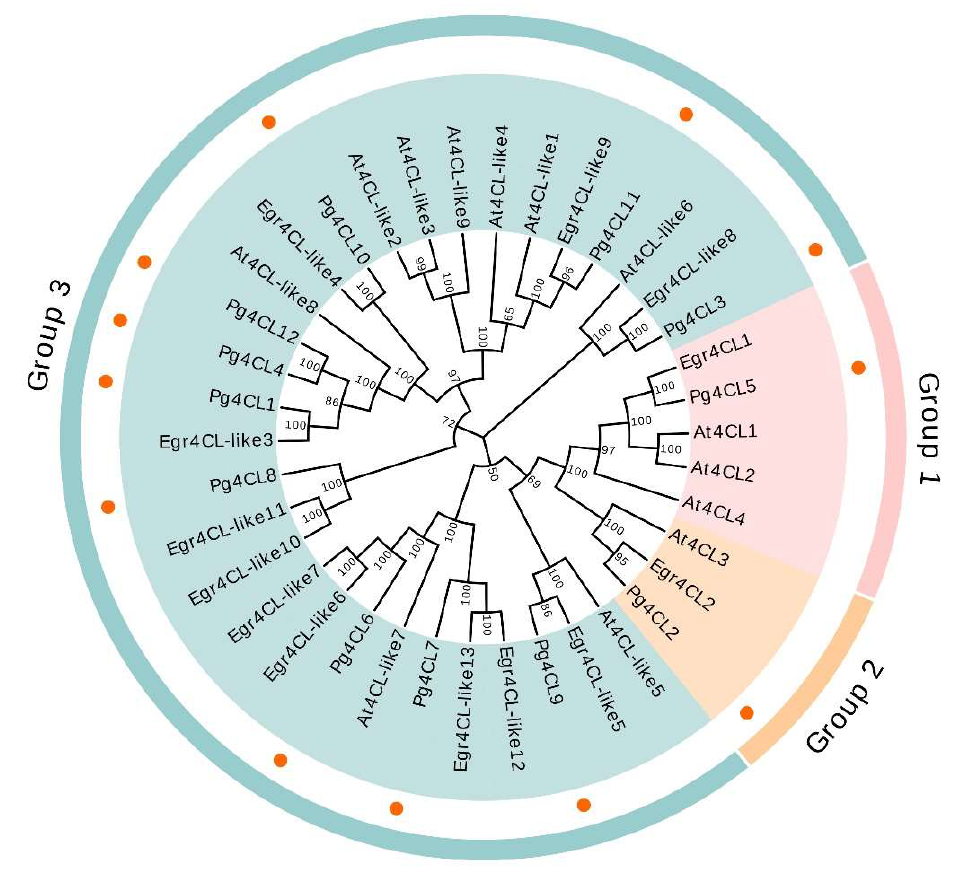
Figure 5. The phylogenetic tree of the 4CL gene family in A. thaliana , E. grandis , and P. granatum. The phylogenetic tree was constructed by using the neighbor-joining method with 1000 bootstrap replications. The prefixes At, Egr, and Pg stand for A. thaliana , E. grandis , and P. granatum .